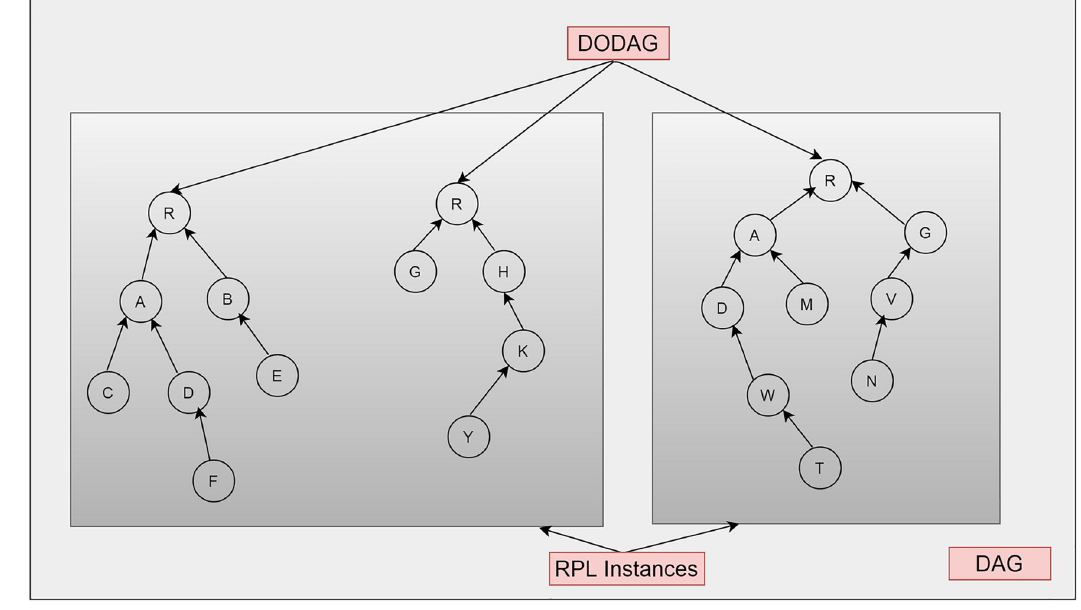
Fig 13. Number of attacks